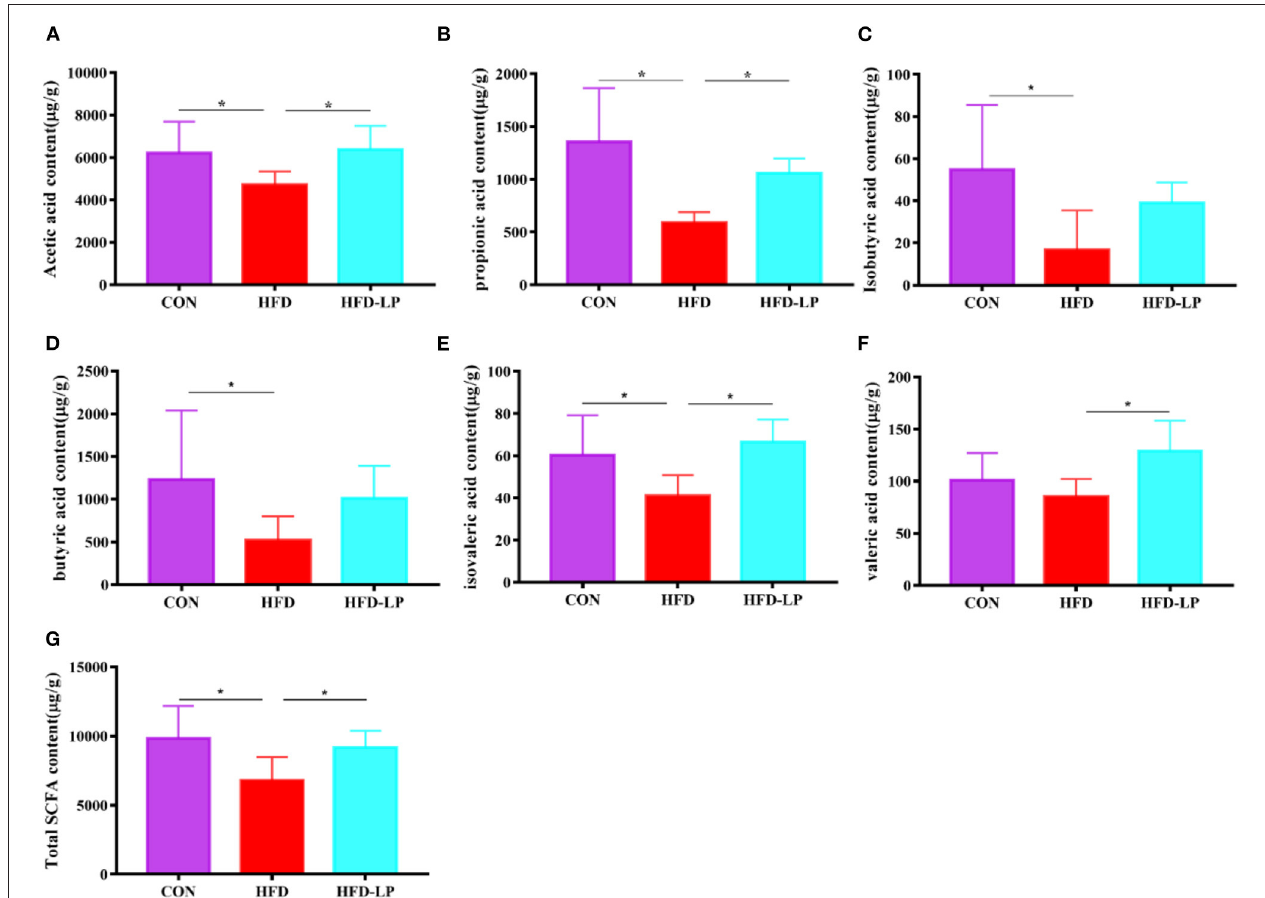
FIGURE 5 | Effect of Lactobacillus plantarum on SCFA in obese mice (A) the content of acetic acid; (B) the content of propionic acid; (C) the content of isobutyric acid; (D) the content of butyric acid; (E) the content of isovaleric acid; (F) the content of valeric acid; (G) the content of total SCFA. Data are mean ± SD ( n = 8) and analyzed by one-way ANOVA. * p <